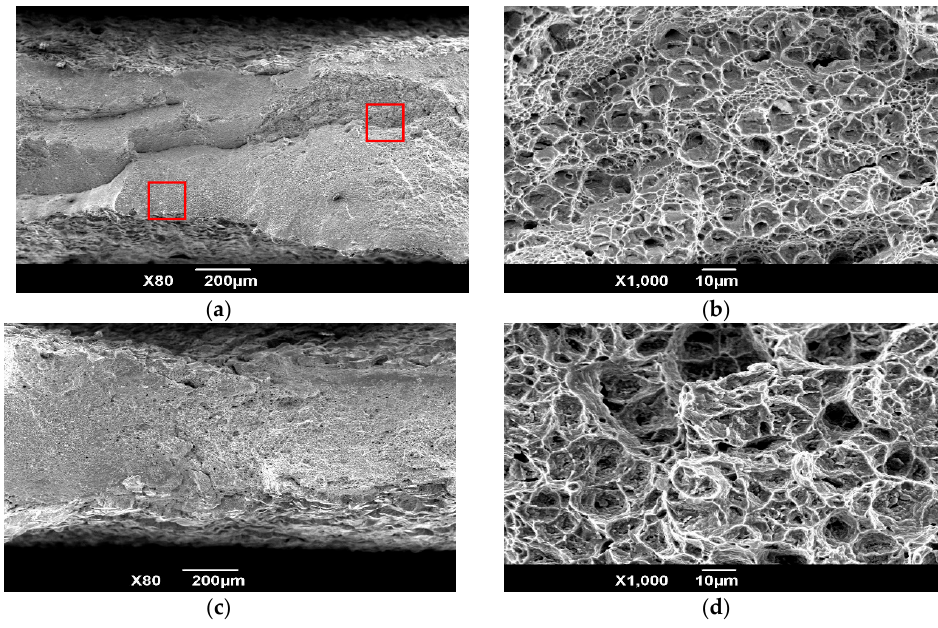
Figure 7. High temperature fractograph under the different deformation temperatures with strain rates of 0.01 s − 1 , ( a ) macro-fractograph at the cross section of the 600 °C tensile samples; ( b ) the enlarged micro-fractograph of the red box in Figure 7a; ( c ) macro-fractograph at the cross section of the 700 °C tensile samples; ( d ) the enlarged micro-fractograph of the red box in Figure 7c.